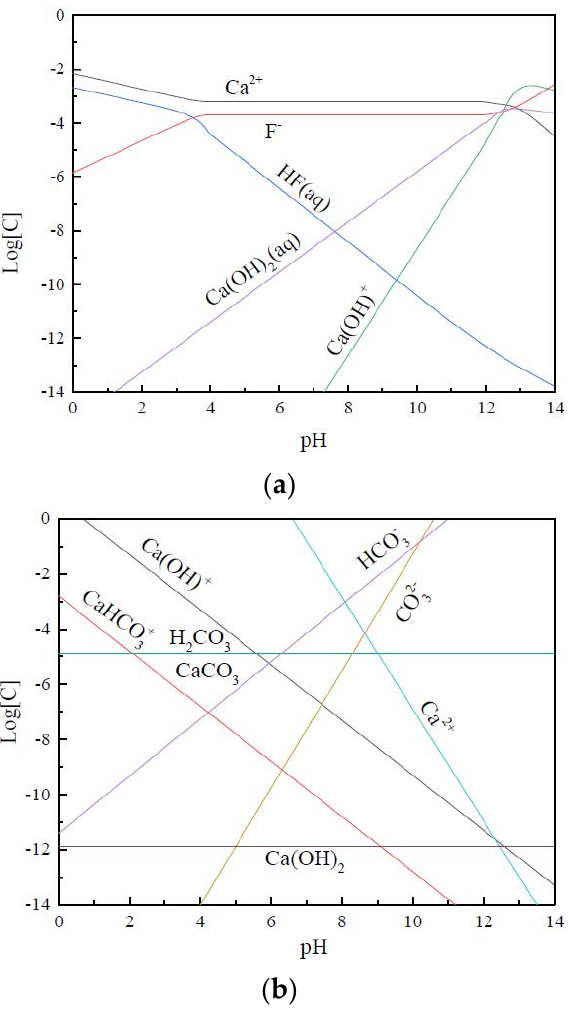
Figure 2. Traditional distribution diagram of fluorite-solution( a ) and calcite-solution( b ) chemistry.